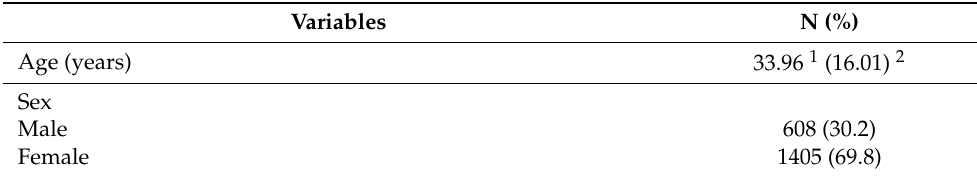
Table 2. Sociodemographic characteristics of the participants in the